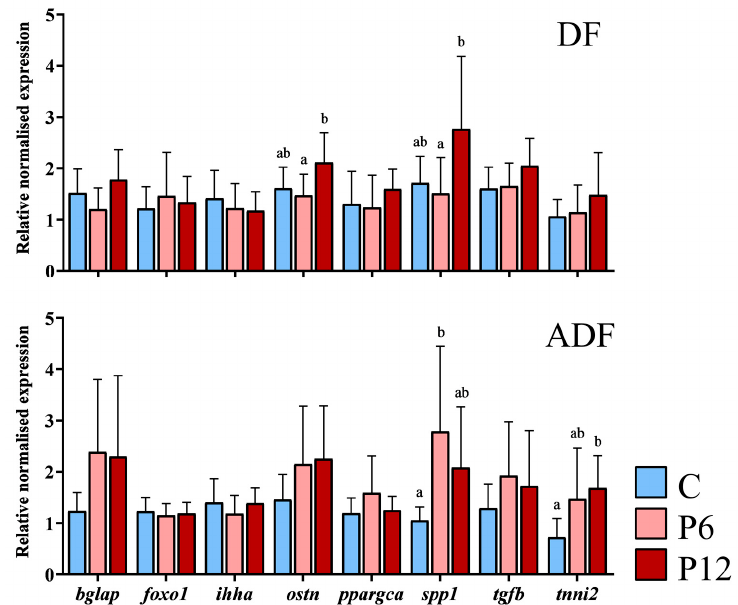
Figure 8. Relative expression of osteocalcin (bglap), forkhead box O1 a (foxo1a), Indian hedgehog signaling molecule a (ihha), osteocrin (ostn), peroxisome proliferator-activated receptor gamma coactivator 1 alpha (ppargca), osteopontin (spp1), transforming growth factor beta 1b (tgfb1b) and troponin I type 2a (tnni2a) after the SCT, between the experimental diets (C, P6, P12) and according to feeding regimes (DF and ADF). Values are presented as means ± SD. Statistically signi fi cant differences between the diets are indicated by the absence of a common le tt er ( n = 3–6 pooled samples of three individuals per diet and gene, p < 0.05).